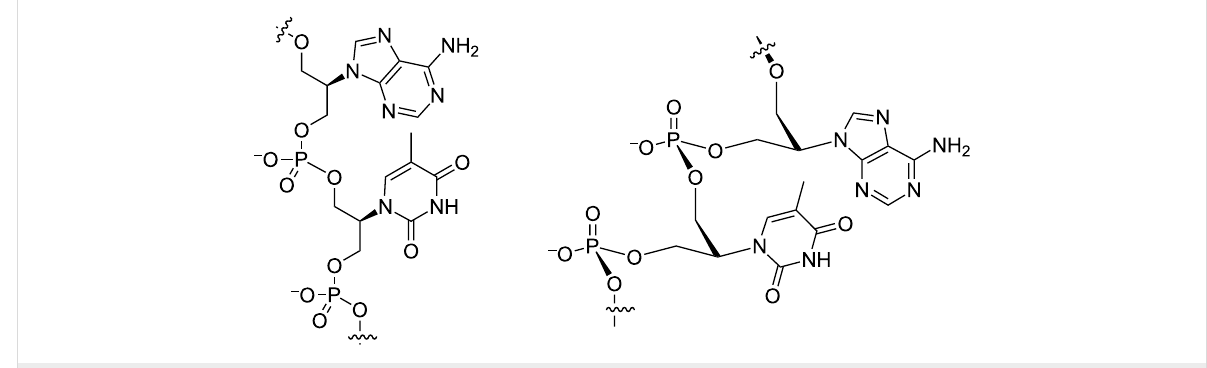
Figure 1: A constitutional and conformational (idealized) representation of isoGNA, an isomer of glycerol nucleic acid.